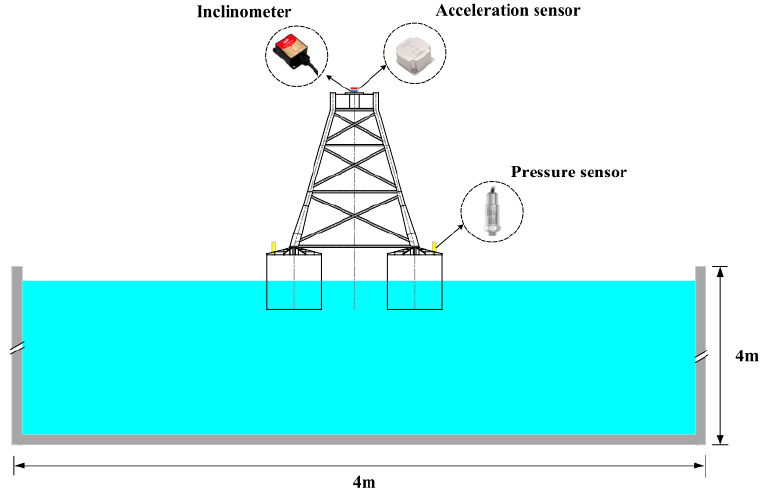
Figure 7. Schematic illustrating the static stability test.